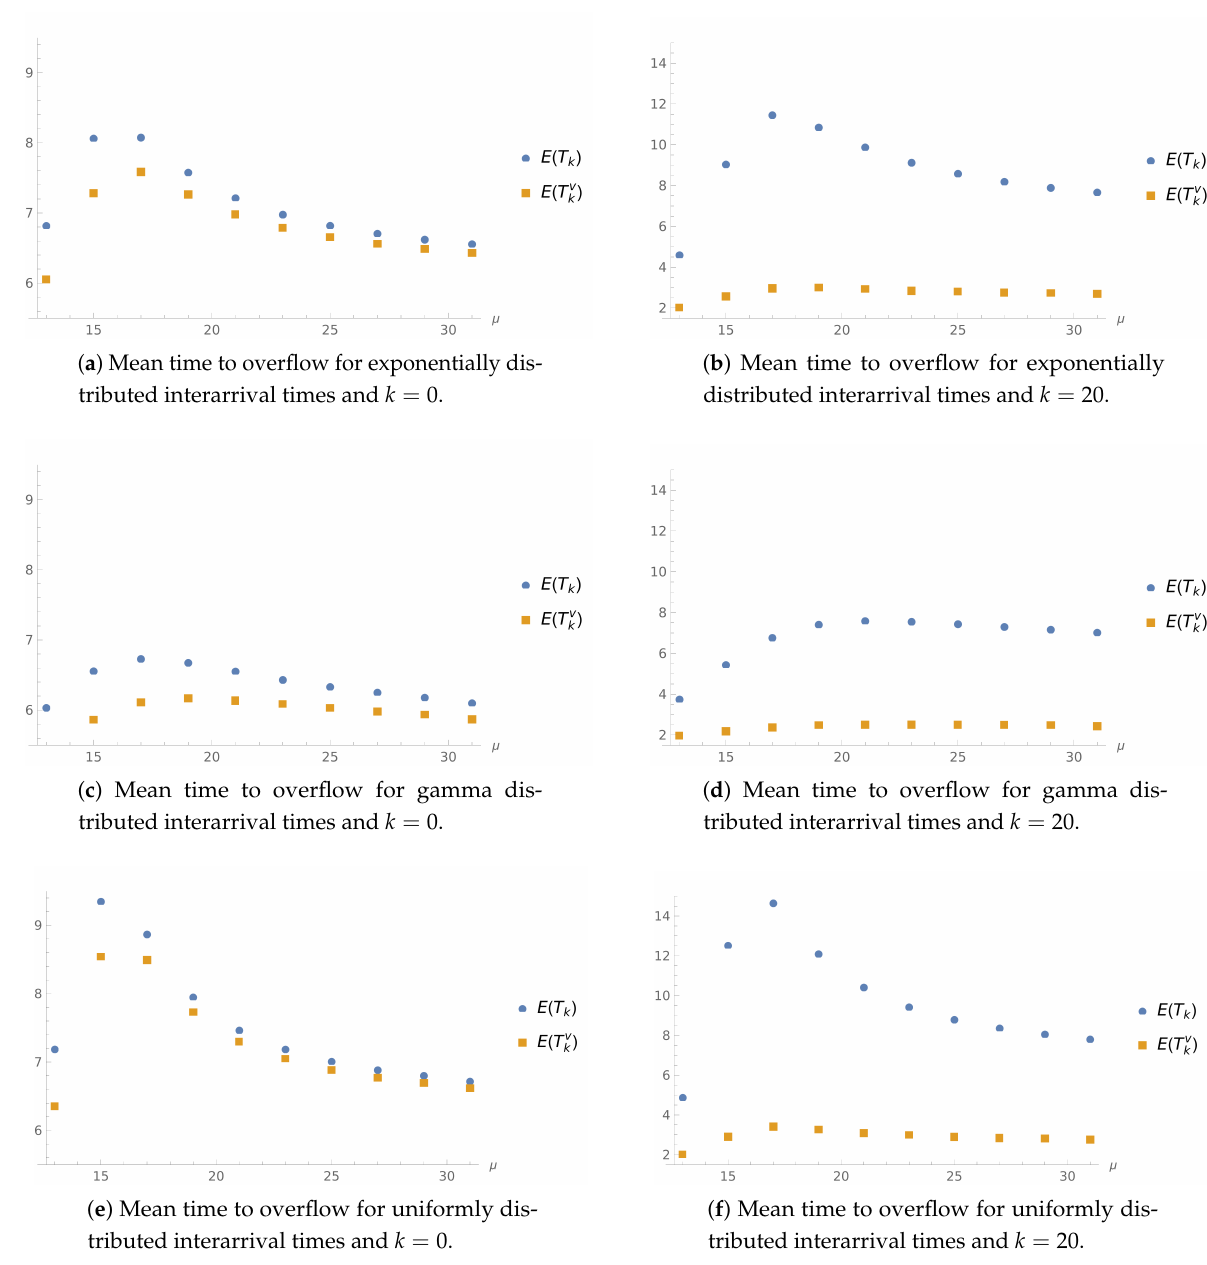
Figure 6. Mean value of the time to buffer overflow for different interarrival distributions with λ ≈ 15, µ v = 9, and 1/ α =